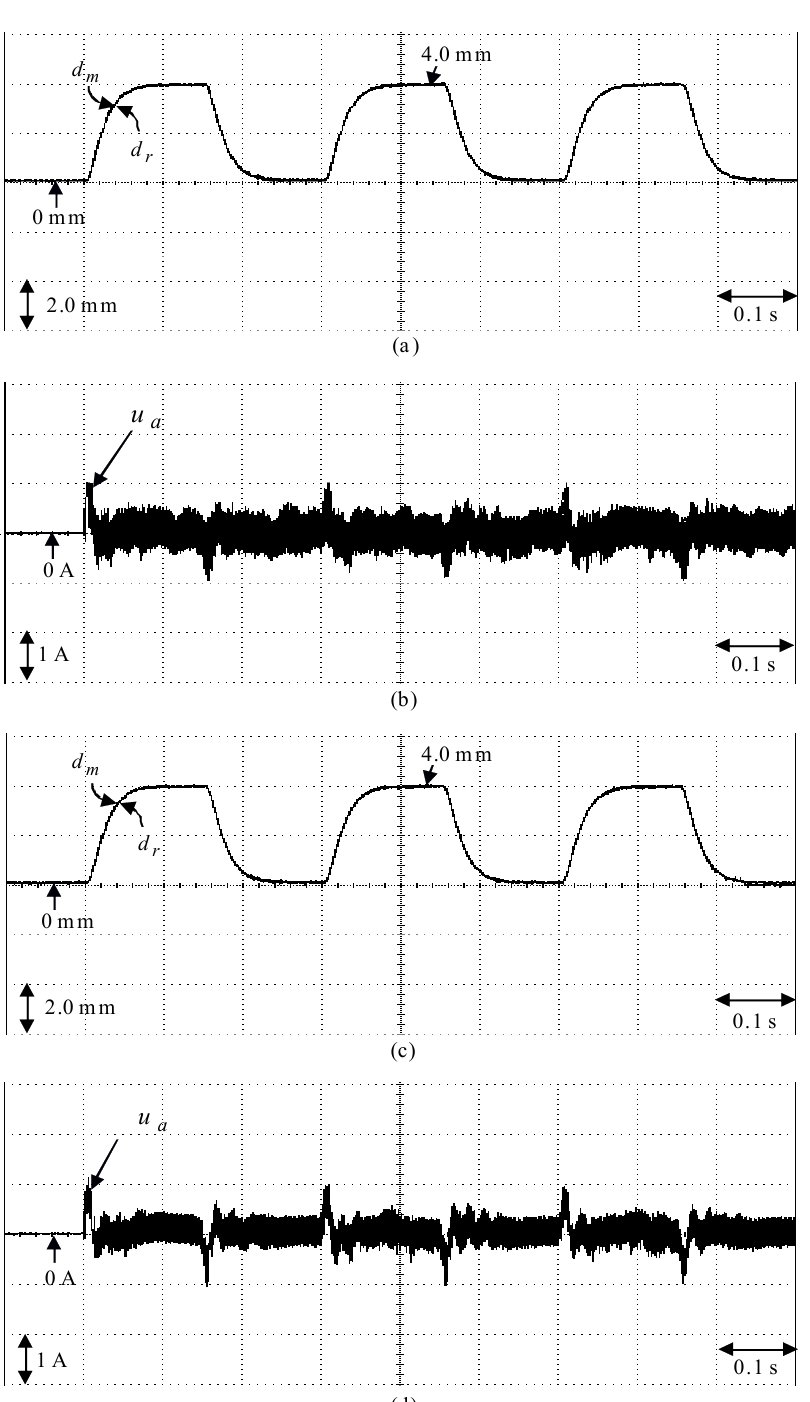
Figure 12. Experimental results of the posed backstepping control system due to periodic step command from 0 mm to 4.0 mm: ( a ) position reaction of the mover in Case 1, ( b ) reaction of control effort in Case 1, ( c ) position reaction of the mover in Case 2, ( d ) reaction of control effort in Case 2.